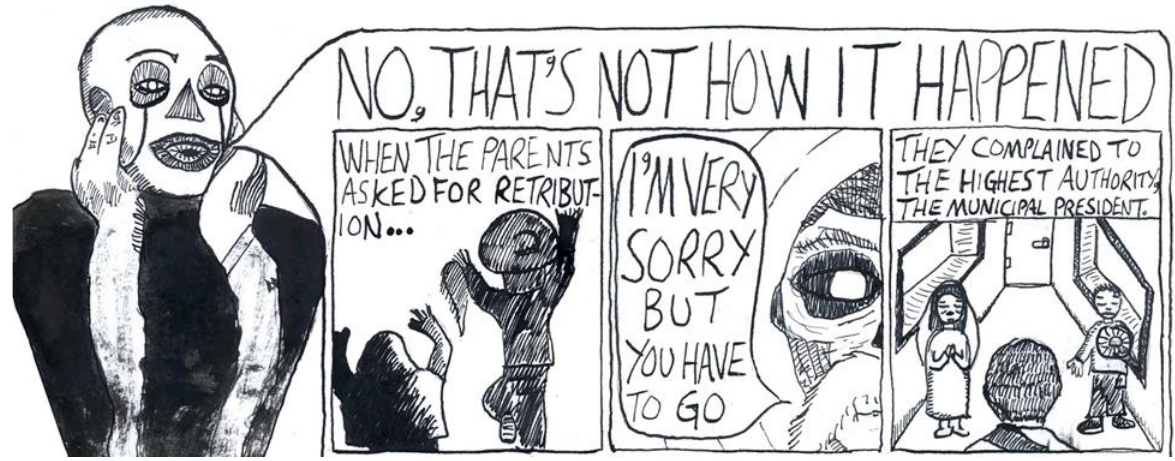
Figure 5: “No, that’s not how it happened” – what my great-aunt said when I fact-checked a story about her great grandfather Justo (Sherwood Gonzalez 2019,